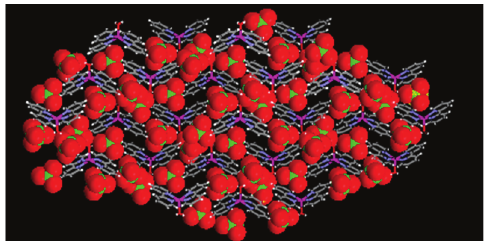
Figure 2. Model of complex {[Zn(bipy) 2 (H 2 O)](ClO 4 ) 2 }( 1 ) .